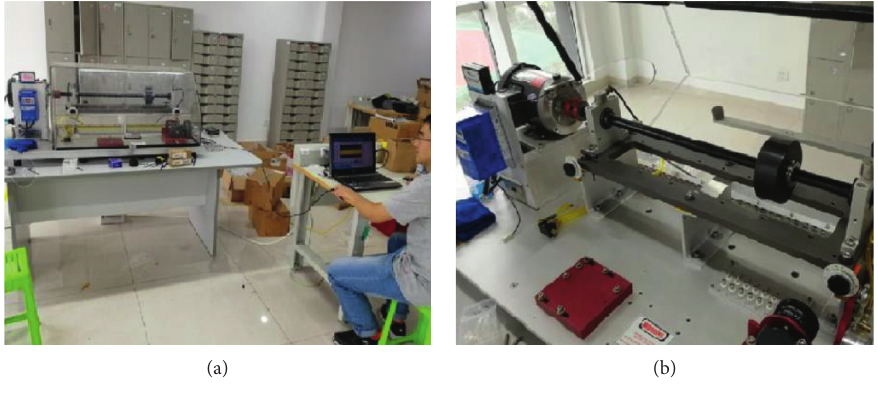
Figure 3: Experimental platform 2 (SQI-MFS).